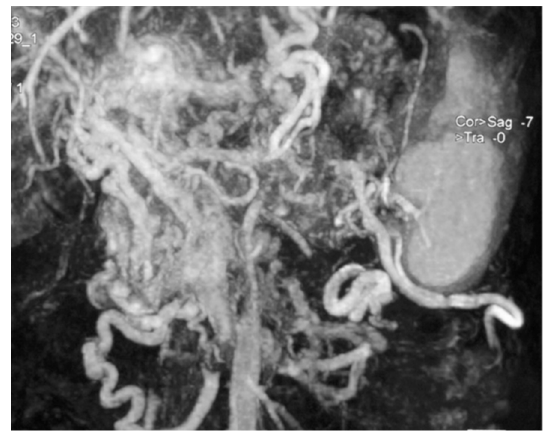
Figure 3. Abdominal magnetic resonance imaging showing several huge mesenteric and left gastric vein compensation collateral circles due to portal vein thrombosis and portal hypertension (case n.6).